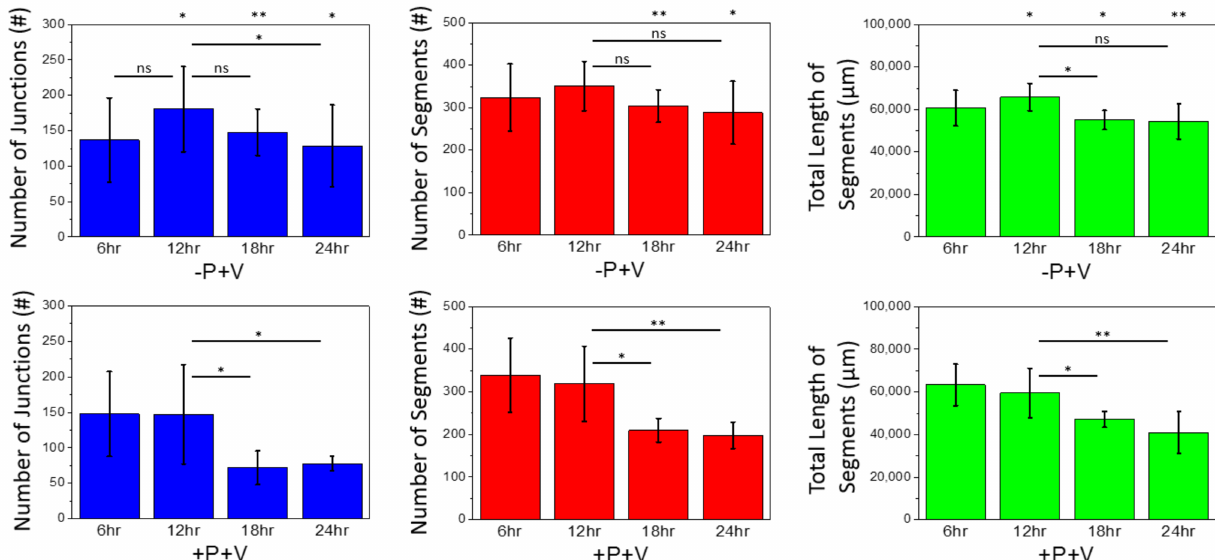
Figure 6. Junction number, segment number, and total segment length of the capillary-like network. The higher value of these three indicators, the more integrity of the network. All experiments were repeated five times. Data are presented as mean SD. The Student’s t-test was performed for statistical evaluation: * = p < 0.05, ** = p < 0.01, and ns = non-significant. The asterisk above the -P+V charts presents the p -value between the − P+V and +P+V cases at the same observation